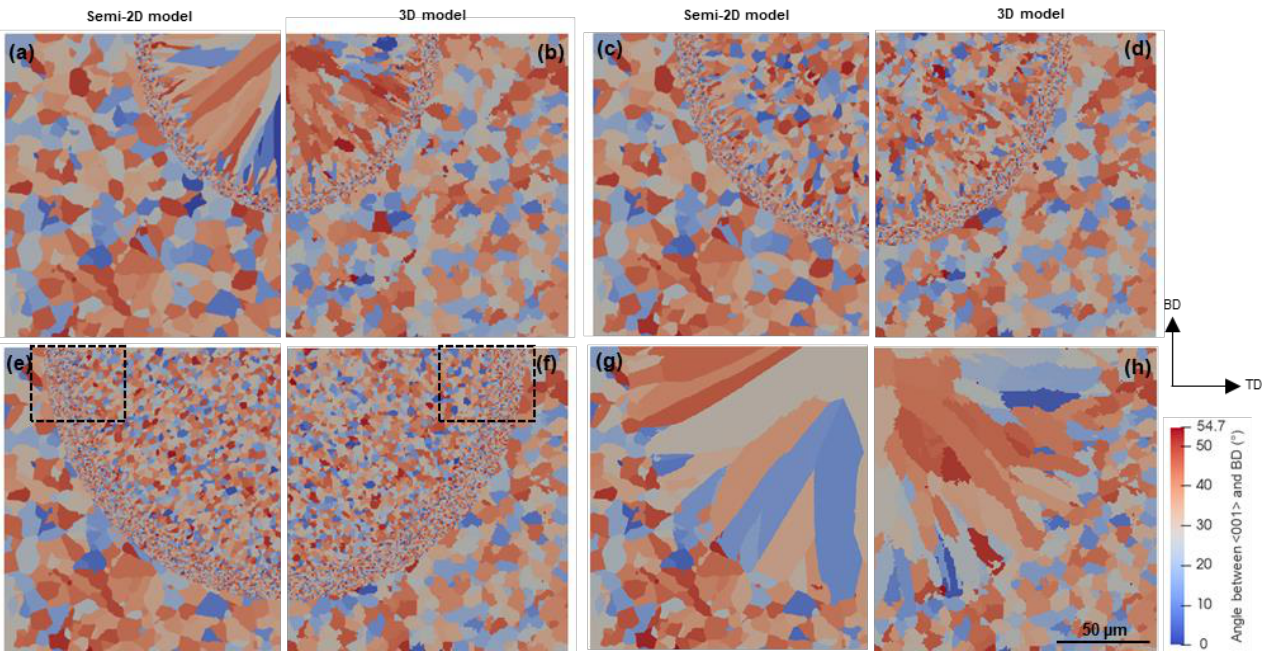
Figure 12. SD sections of CA microstructures obtained by semi-2D simulation with a cell size of 250 nm ( a , c , e , g ) and 3D simulation with a cell size of 1 µm ( b , d , f , h ) at ( a , b ) scanning speed of 1000 mm/s and platform temperature of 298 K, ( c , d ) scanning speed of 500 mm/s and platform temperature of 298 K, and ( e , f ) scanning speed of 500 mm/s and platform temperature of 473 K. Microstructures ( g , h ) obtained under the same scanning conditions of ( e , f ) without the particle-based nucleation. Figure 13 shows a higher magnification of the areas marked by frames in ( e , f ).